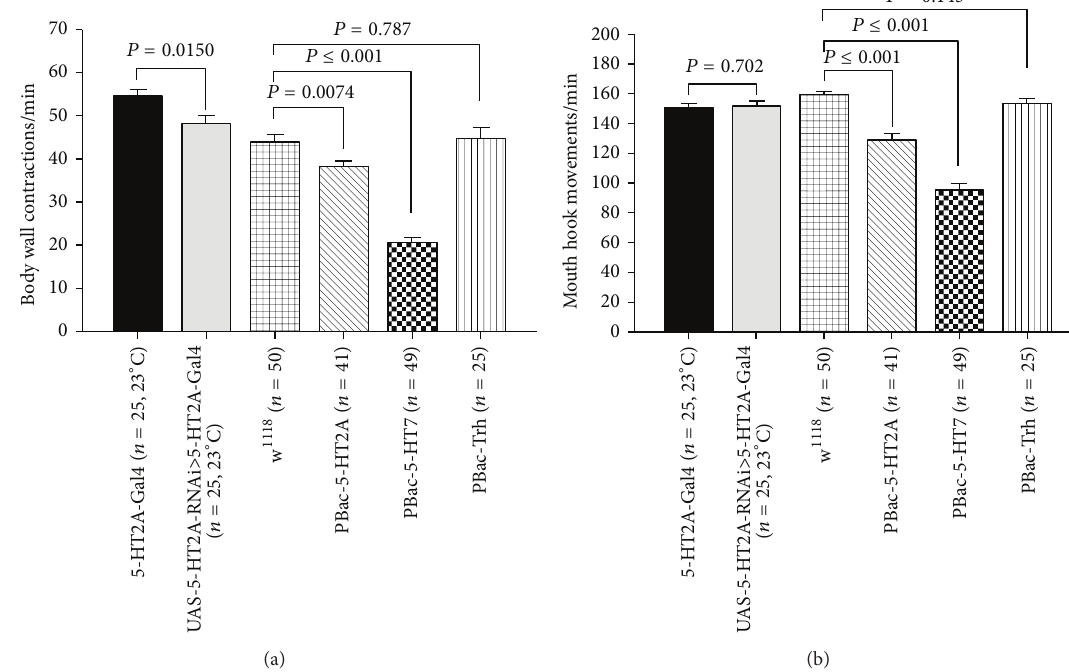
Figure 7: Serotonergic system dysregulation and behaviors. (a) Homozygous insertional mutations in 5-HT2A and 5-HT7 receptors significantly reduced body wall contractions in third-instar larvae. However, homozygous insertional mutation in 5-HT biosynthesis rate- limiting enzyme, tryptophan hydroxylase (Trh), did not have a significant effect on body wall contraction in comparison to w 1118 group. (b) Homozygous insertional mutation in 5-HT2A and 5-HT7 receptors significantly reduced mouth hook movements in third-instar larvae. However, 5-HT2A receptor knockdown and homozygous Trh mutant larvae did not show noticeable effect on mouth hook movements. Student’s 𝑡 -test was performed to carry out comparison between groups. Data presented as mean ± SEM.